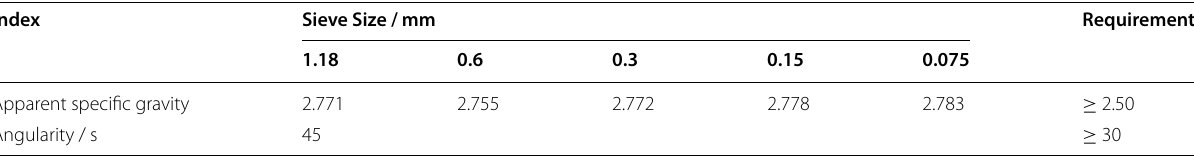
Table 2 Basic properties of fine aggregate